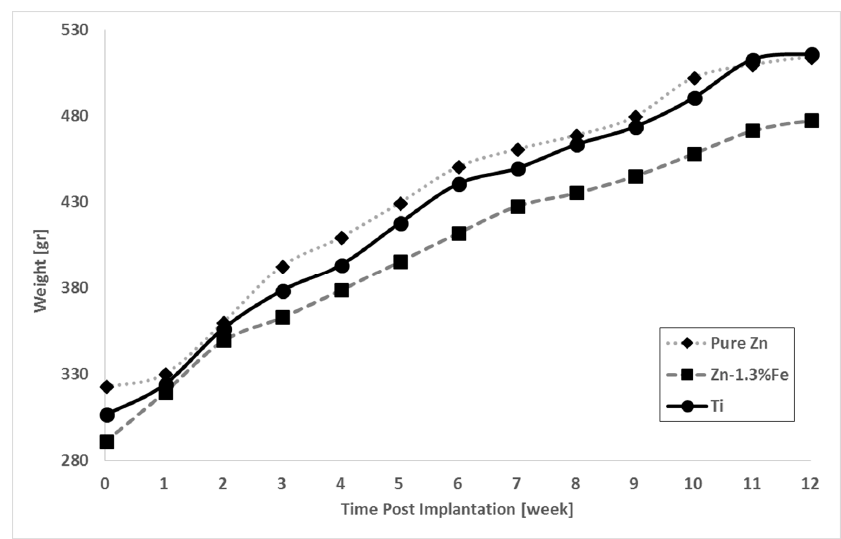
Figure 10. Rat body weights pre- and post-implantation.